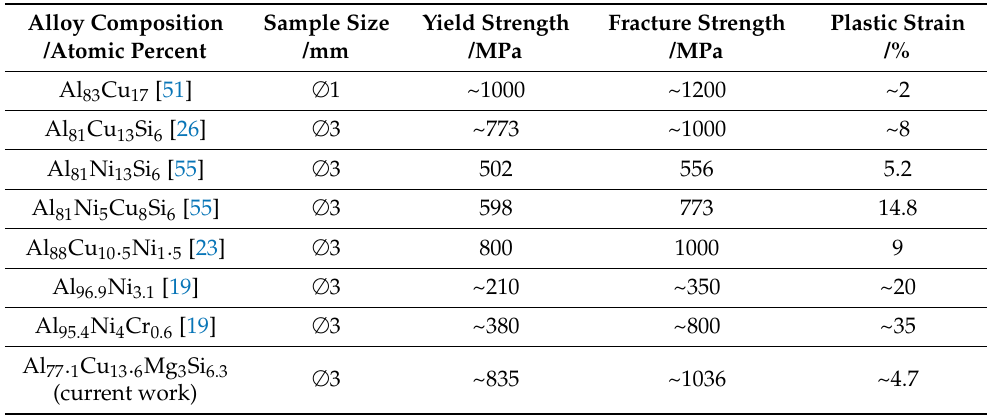
Table 1. The compressive mechanical properties of current and reported Al-based ultrafine eutectic